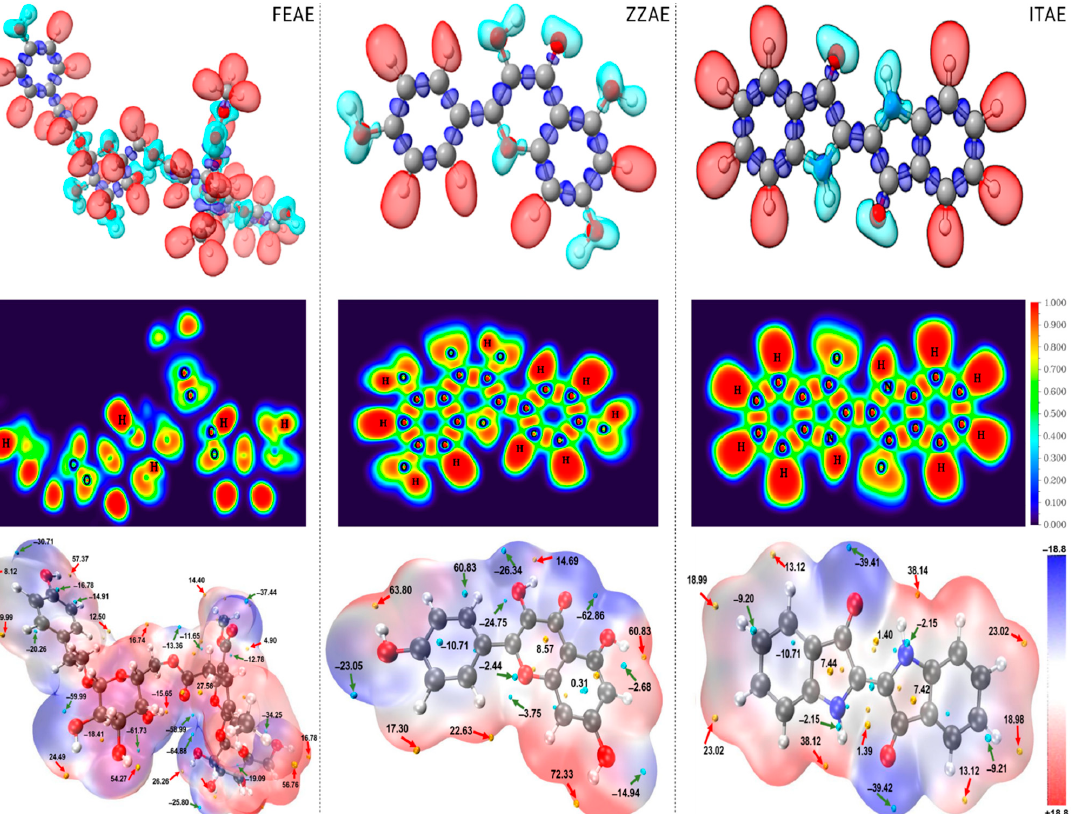
Figure 9. The electron localization function (ELF) isosurfaces (color code: cyan for lone pair domains, red for hydrogen-related domains blue for bonding domains between heavy atoms; isosurface 0.796 a.u.), ELF color-filled maps in the XY plan and electrostatic potential (ESP) mapped vdW surface (color code: orange and blue spheres correspond to ESP maxima and minima on the vdW surface, respectively; isosurface 0.001 a.u.). (ELF isosurfaces: top, ELF color-filled maps: middle row, ESP: bottom row).